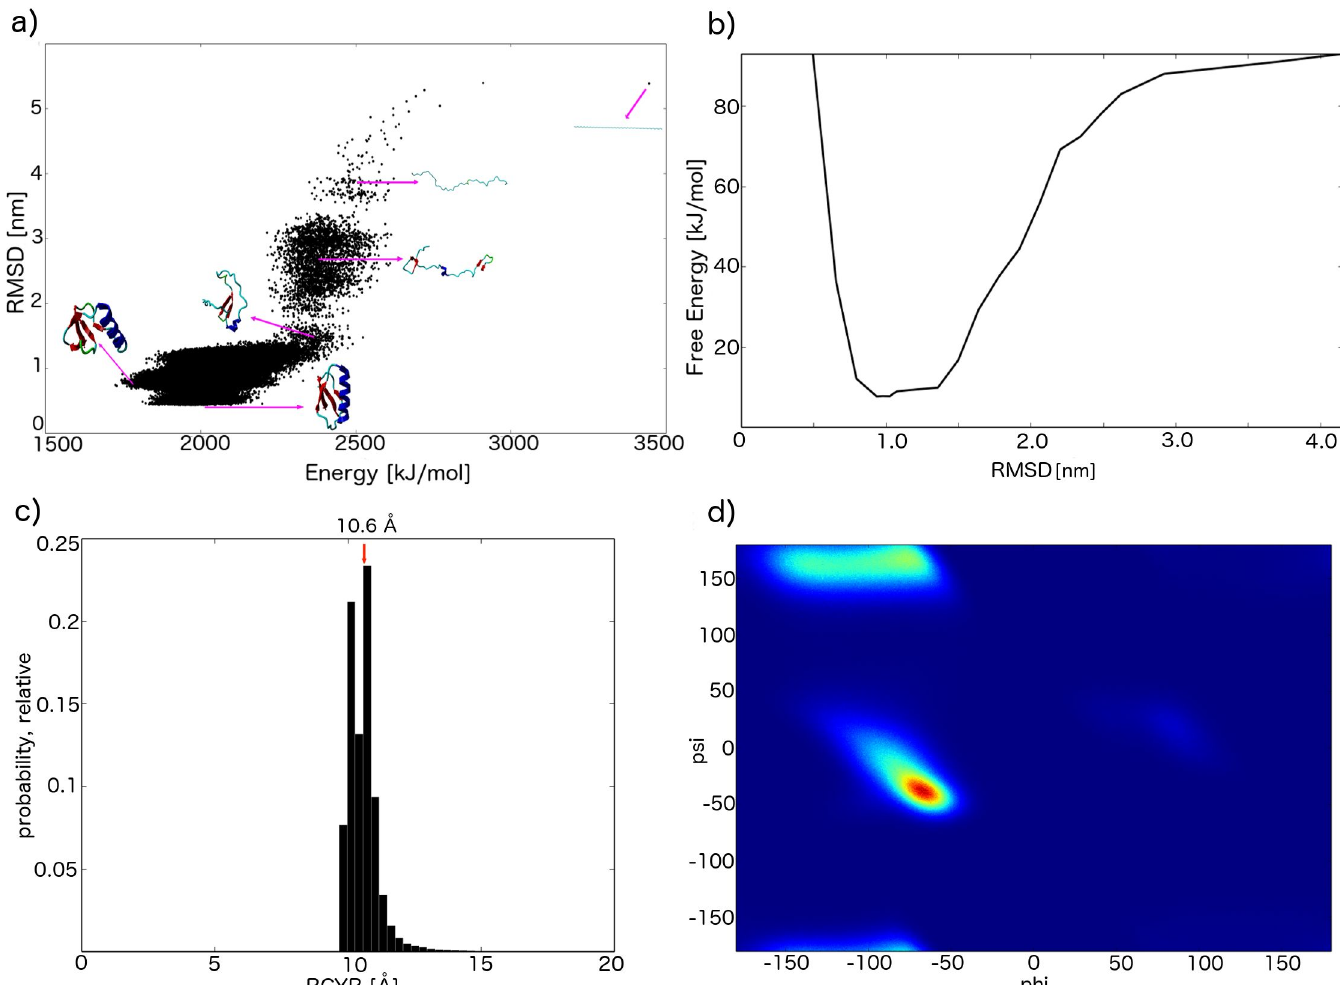
Fig 4. Folding of GB3 using the CamTube force field. (a) CamTube energy generated from an unbiased 1 μ s long molecular dynamics simulation of GB3 as a function of the RMSD from the crystal structure, PDB ID: 2OED. Representative structures sampled in different regions of ( energy , rmsd ) space are shown as insets. (b) Free energy of Val60 obtained from a metadynamics simulation and the CamTube force field as a function of the RMSD from the crystal structure, PDB ID: 2OED. (c) Distributions of the radius of gyration; the radius of gyration of the native state of GB3 (PDB ID: 2OED) is indicated by the red arrow. (d) Ramachandran plot for the GB3 structures generated by the CamTube force field.